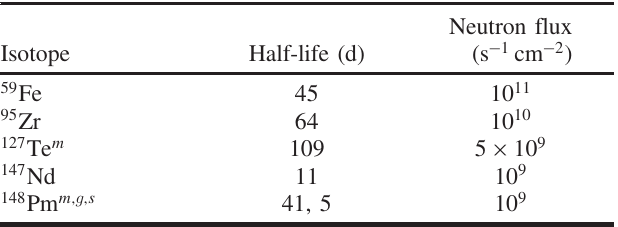
TABLE I. Interesting branch point nuclei in the s -process nucleosynthesis network, which cannot be directly measured with current or upcoming facilities. The last column gives an estimate for the minimum neutron flux necessary in the keV regime at the sample position for a traditional time-of-flight measurement using a 4 π calorimenter to detect the emitted γ rays